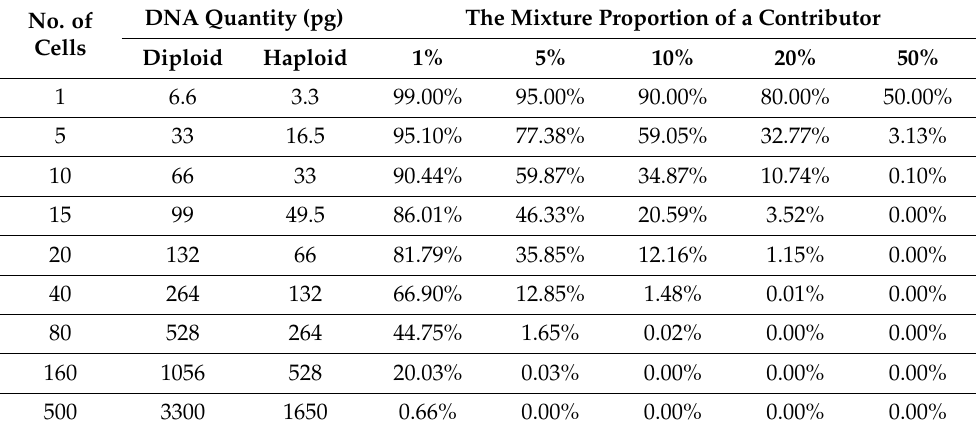
Table 2. The probability of not detecting a minor contributor in a set of single-cell